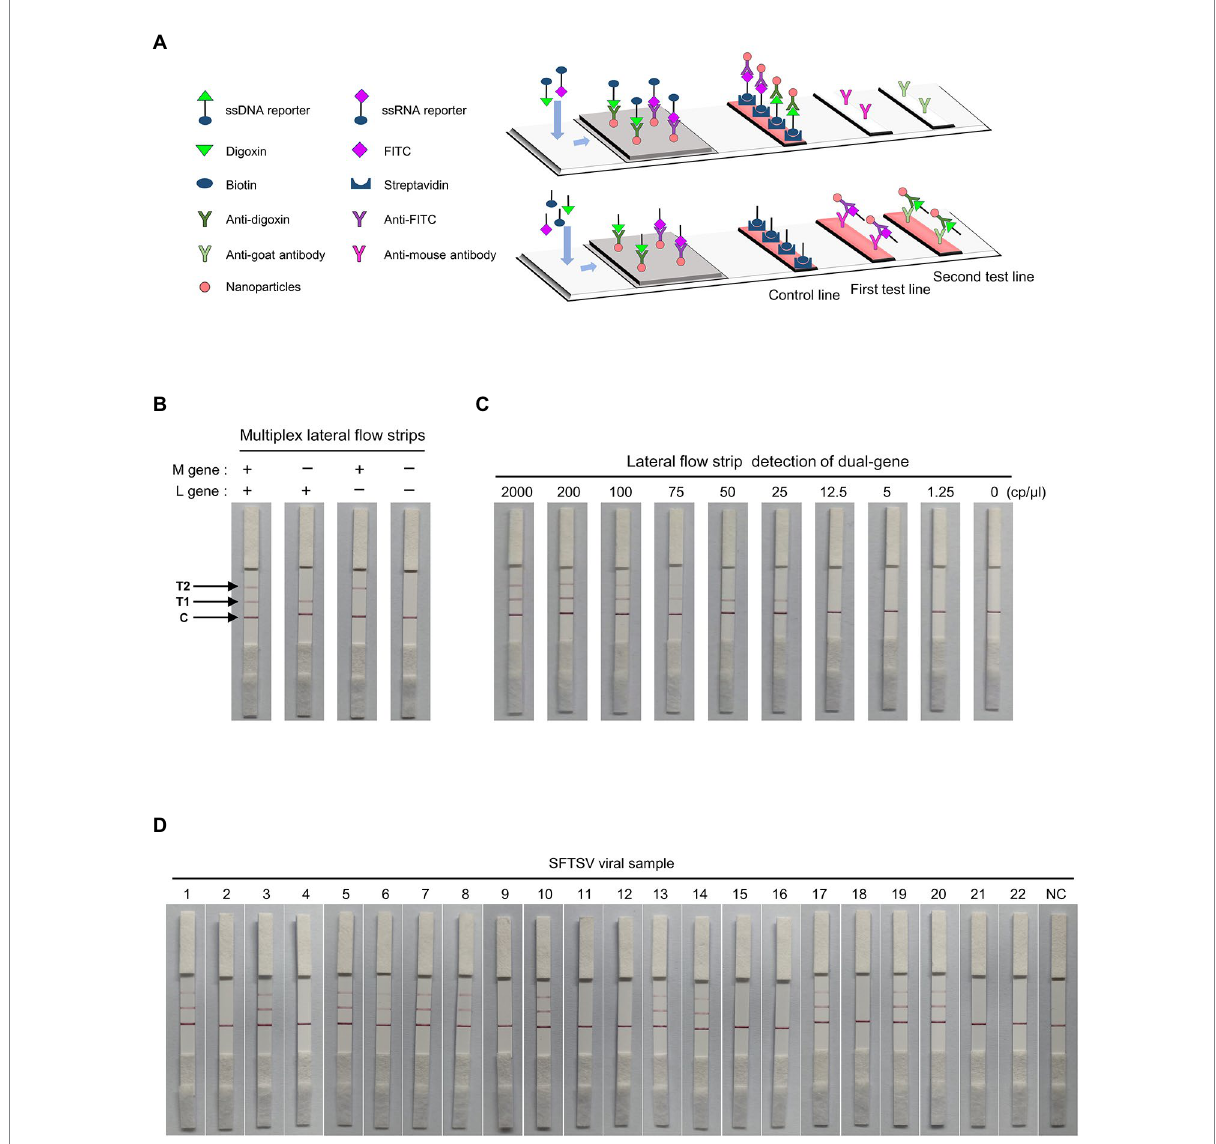
FIGURE 5 SFTSV nucleic acid detection combined with immunochromatography. (A) Schematic diagram of the multiplexed test strips. (B) The multiplexed test strip assay readout. The positive result requires detection of at least one of the two targets (L gene at the first target capture line and M gene at the second target capture line). (C) The sensitivity of multiplexed test strips based on the dual-gene detection system using the diluted synthetic RNA standards. (D) The detection results of multiplexed lateral flow strips for 22 clinical samples. NC, no-template